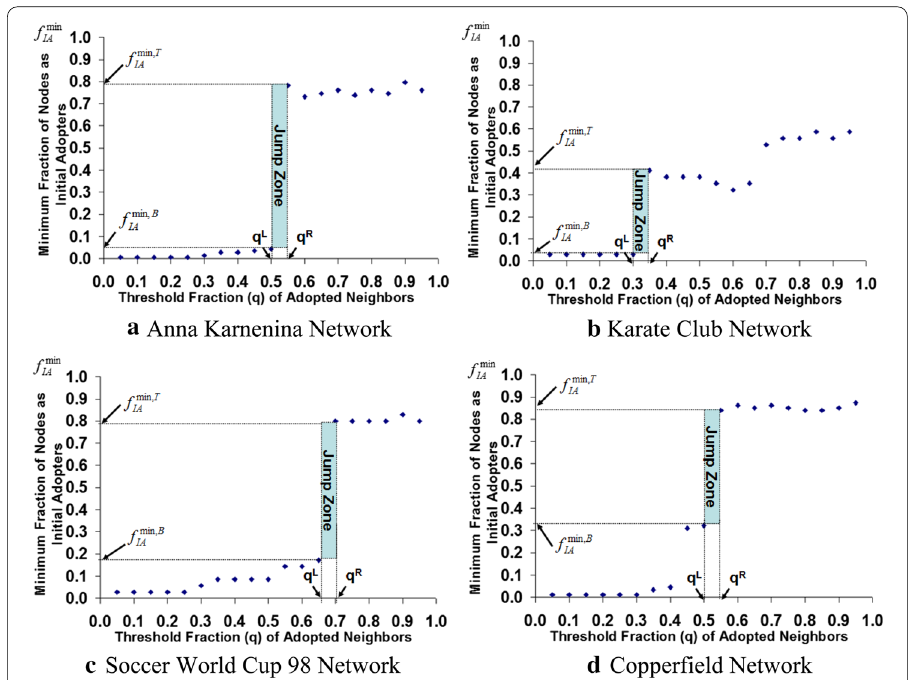
Fig. 3 Step function patterns observed for the q versus f min IA distribution for real-world networks with respect to degree centrality